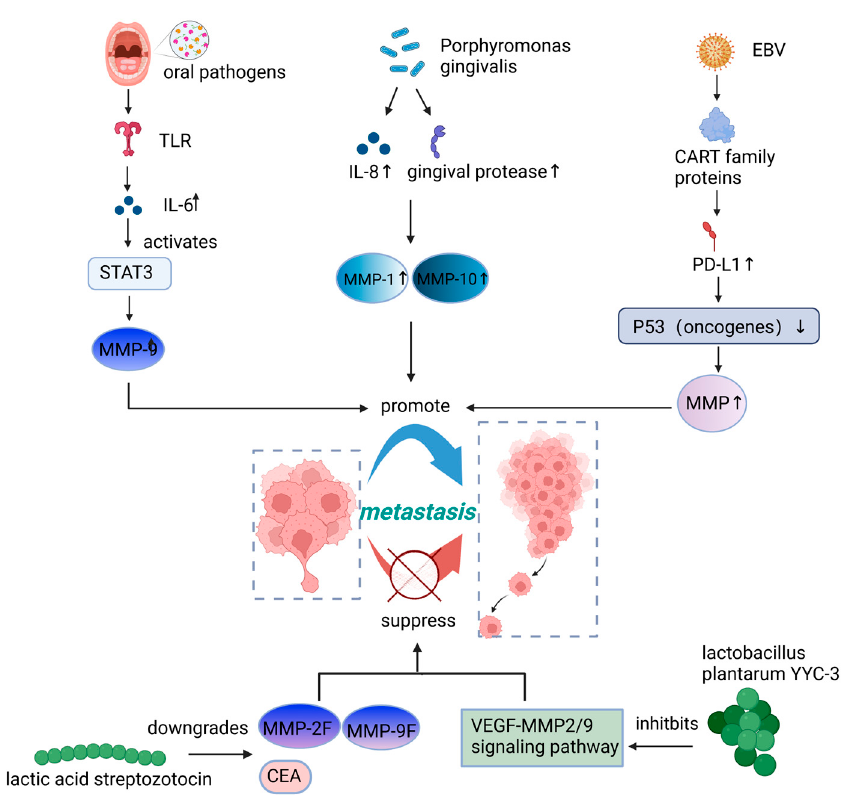
Figure 3. Microbiome affects cancer metastasis by regulating Matrix metalloproteinases (MMPs). PD-L1, programmed cell death protein 1 ligand; CEA, carcinoembryonic antigen. Figure created with BioRender.com on 14 January 2023.